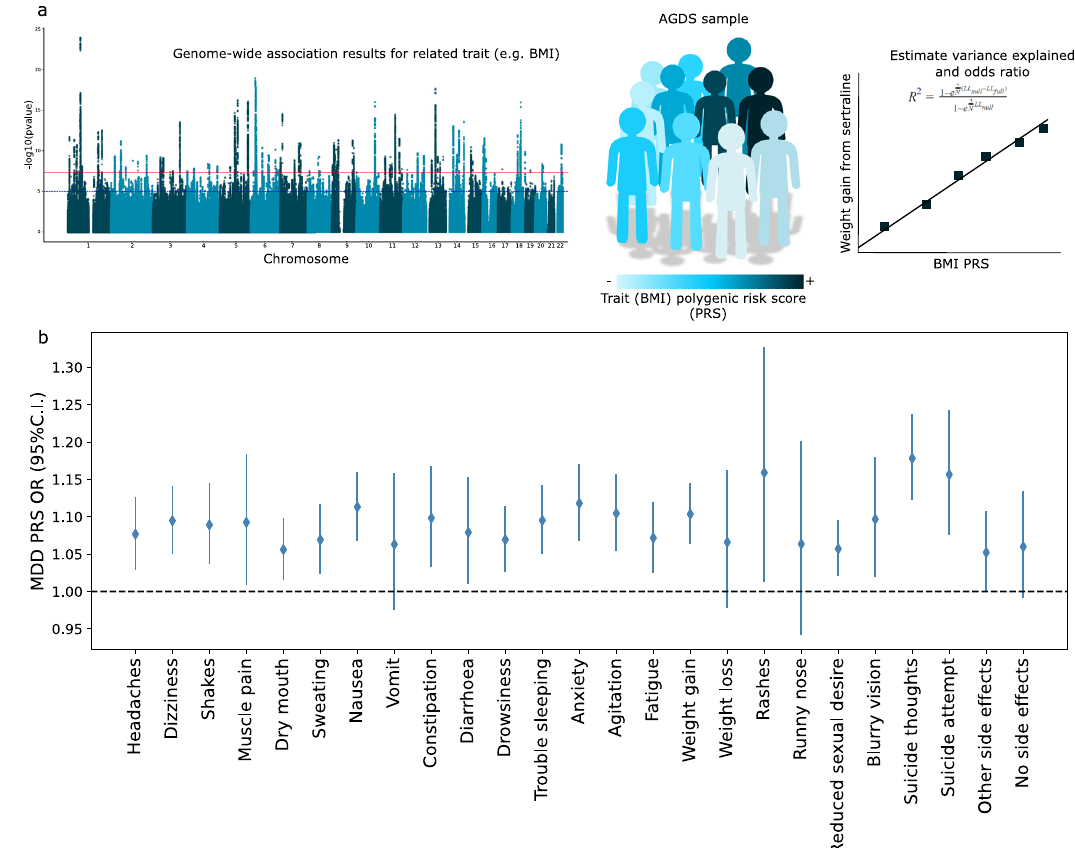
Fig. 3 Genetic factors underlying side effects. a Overview of the polygenic risk scoring approach employed. Results from a published GWAS are used to estimate the polygenic risk for a given trait in the AGDS. These scores can be used to predict the side effect of interest. b Forest plot showing the results, odds ratio (OR) and 95% (C.I.) for the association between MDD PRS and side effects across antidepressants. MDD — major depressive disorder; PRS — polygenic risk